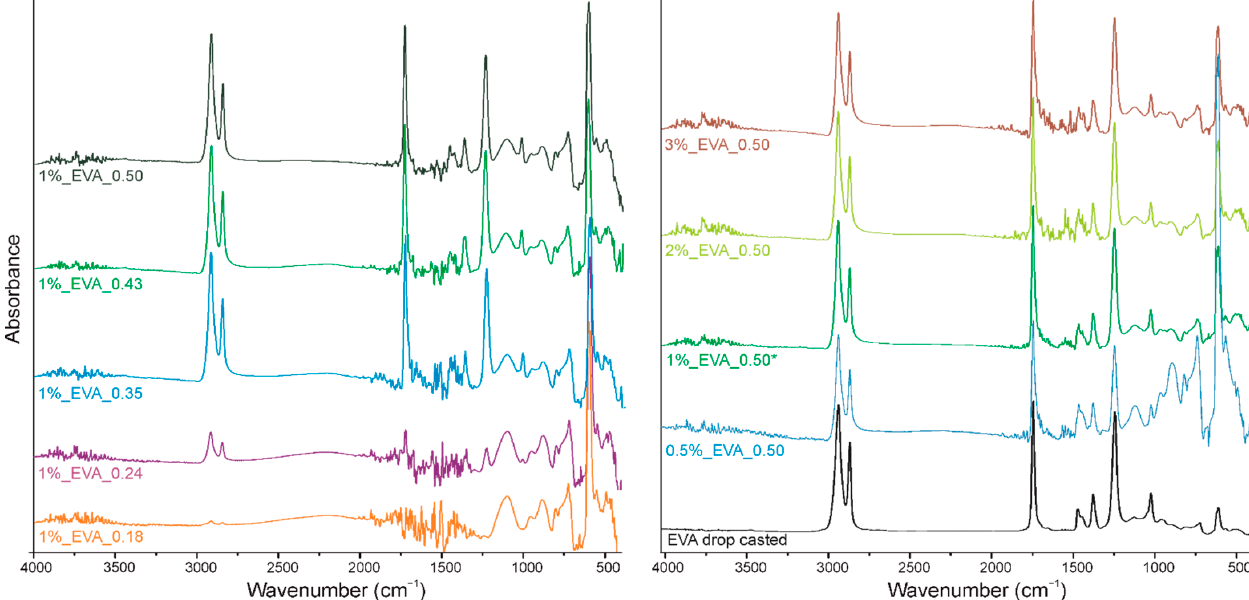
Figure 3. FTIR spectra of two series of EVA films: left with variable laser fluence and right with variable concentrations of the EVA solution.